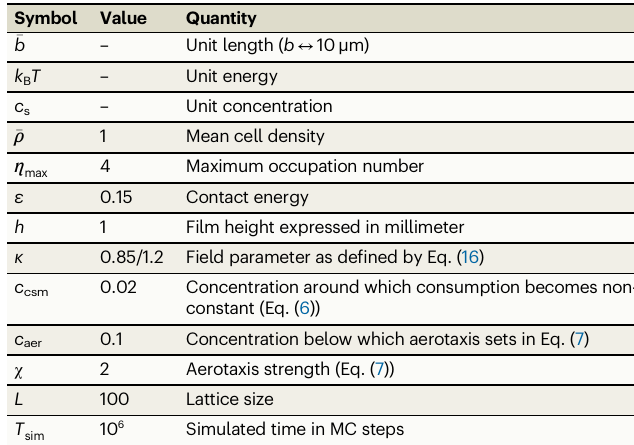
Table 1 | Units and parameters of the